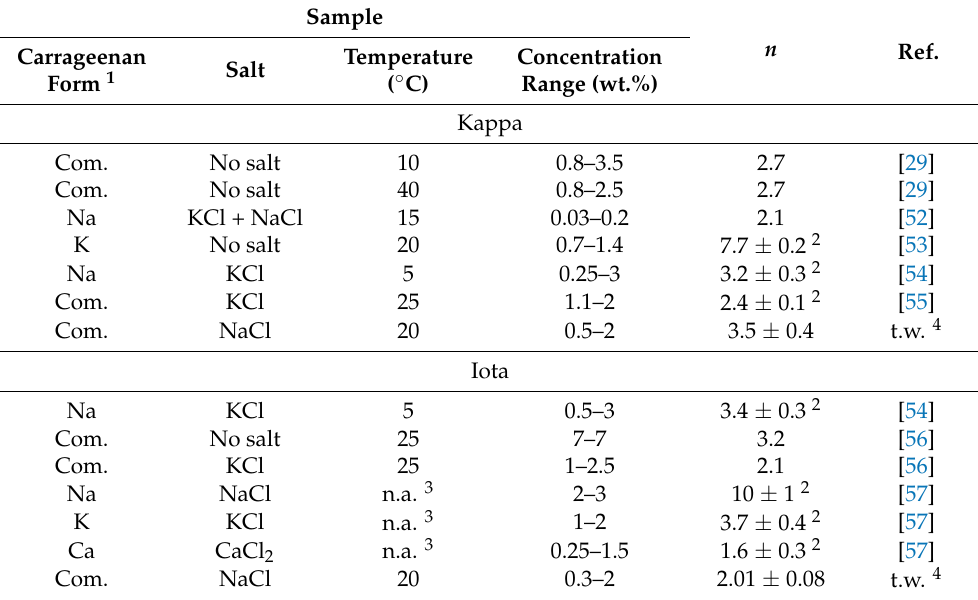
Table 4. Exponents n of the power law equation G 0 = Ac n describing the dependence of the linear shear elastic modulus G 0 on the carrageenan concentration c in gels formed under the conditions detailed in the column “Sample”. The values of constant A used in the fitting of the power equation to the data are not